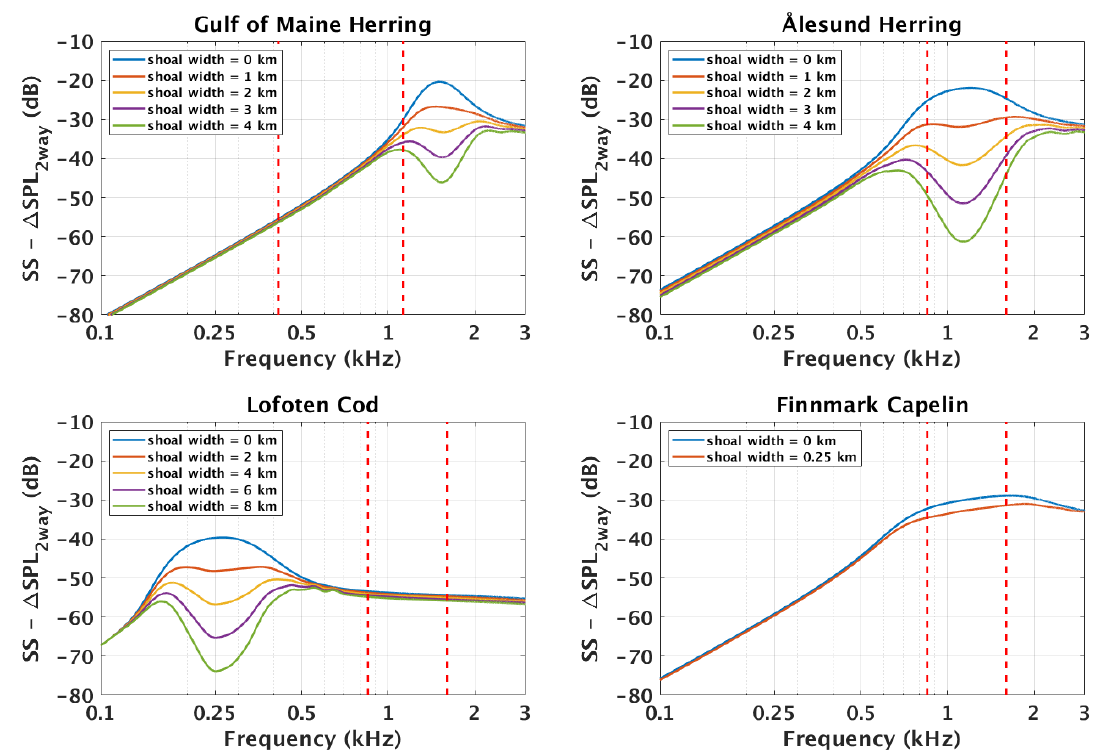
Figure 5. The most favorable acoustic frequency for sensing in an ocean environment can be determined by maximizing the scattering strength uncorrected for two-way attenuation from fish ( SS − ∆ SPL 2 way ) of a target. Here, ( SS − ∆ SPL 2 way ) is modeled for fish shoals in four continental shelf environments: herring in the Gulf of Maine, herring in Ålesund waters, cod in Lofoten waters and capelin in Finnmark waters. The magnitude of attenuation depends on the width of the shoals along the propagation path between the sensing system and the target. When the shoal width along the propagation path is sufficiently small, attenuation will be negligible and the most favorable sensing frequency will be near swimbladder resonance. As the shoal width along the propagation path increases, there will be a tradeoff between frequencies near resonance where scattering strength is highest and off-resonance frequencies where attenuation is lowest. Red dotted lines designate the sensing frequency range of OAWRS experiments in each region. Physical parameters used for modeling each environment are shown in Table